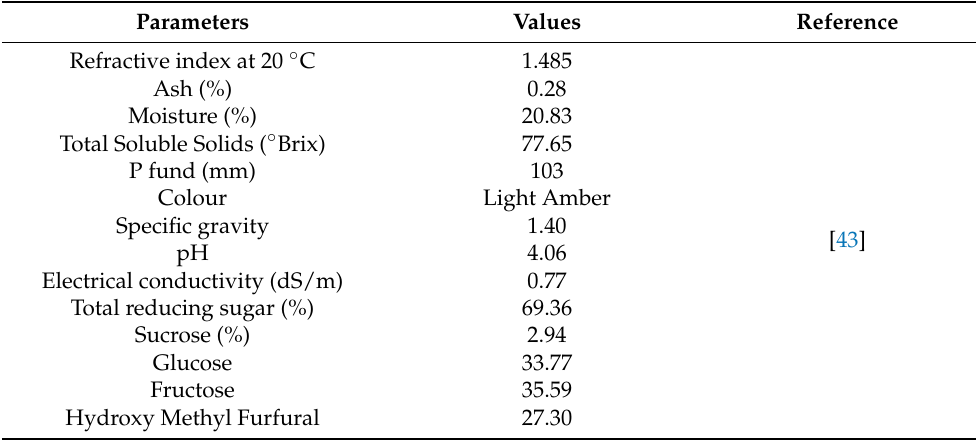
Table 3. Physicochemical parameters of